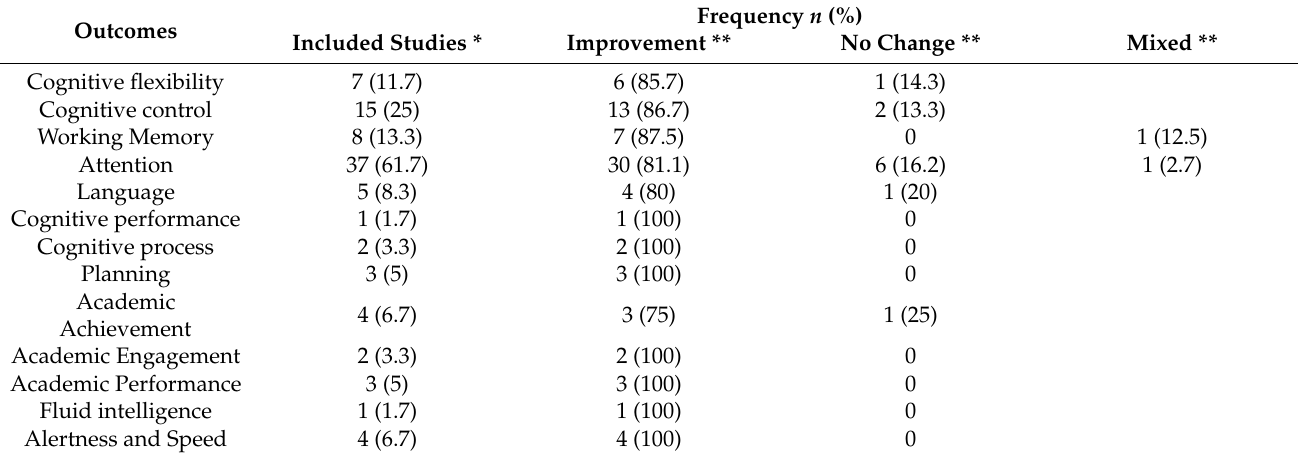
Table 2. Frequency of cognitive outcomes assessed and the direction of